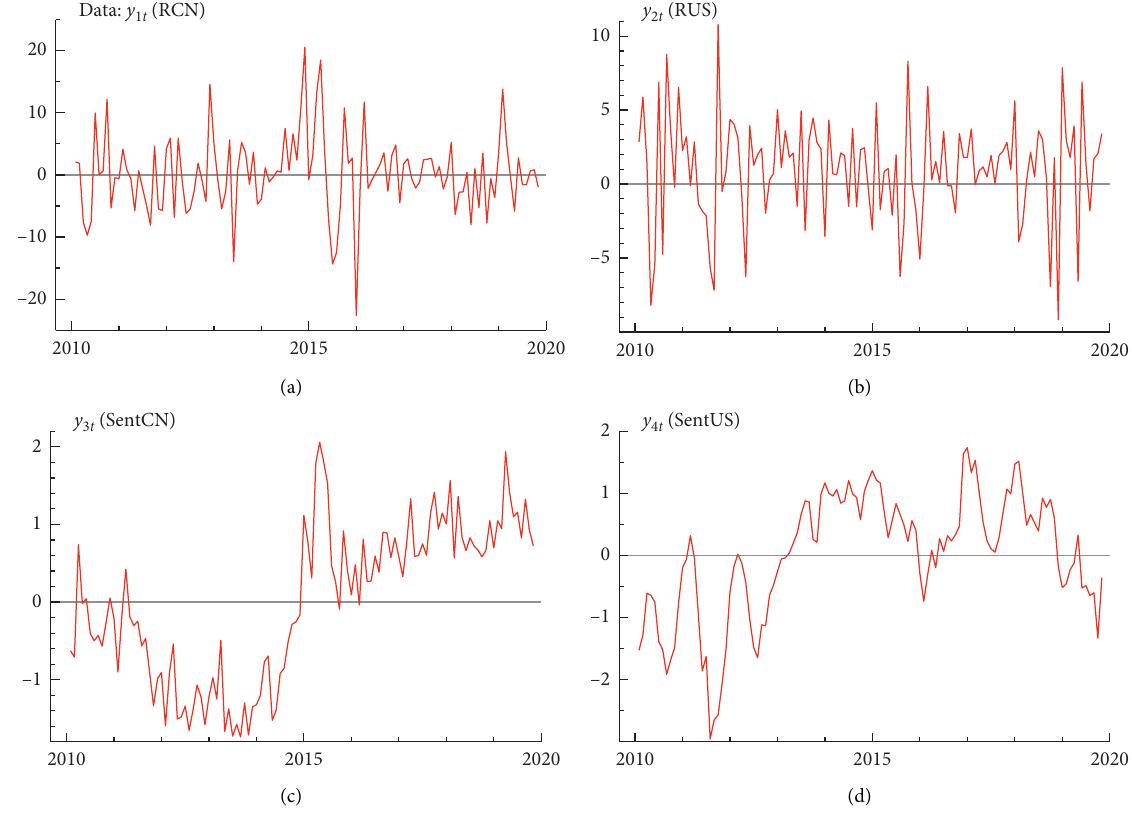
Figure 4: China stock index return, US stock index return, US investor sentiment, China investor